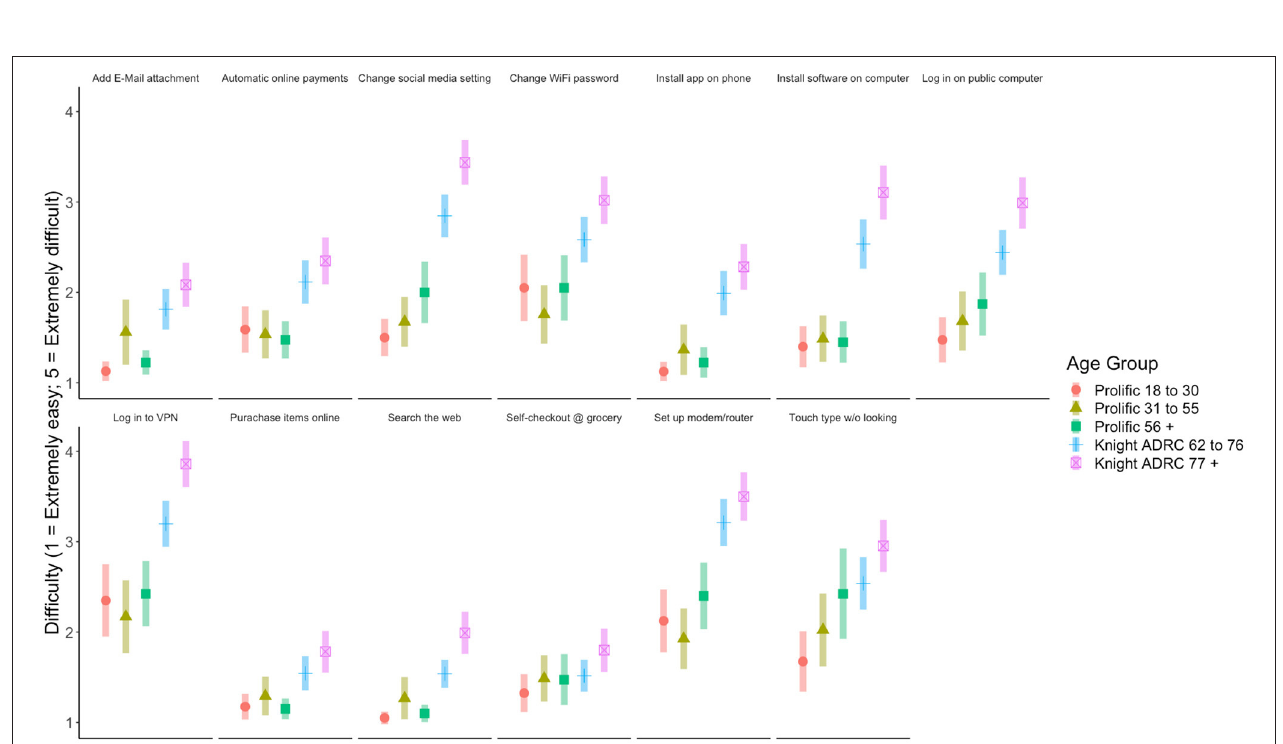
FIGURE 3 | Participants’ reported difficulty performing technology-based tasks. Error bars represent 95% confidence interval.